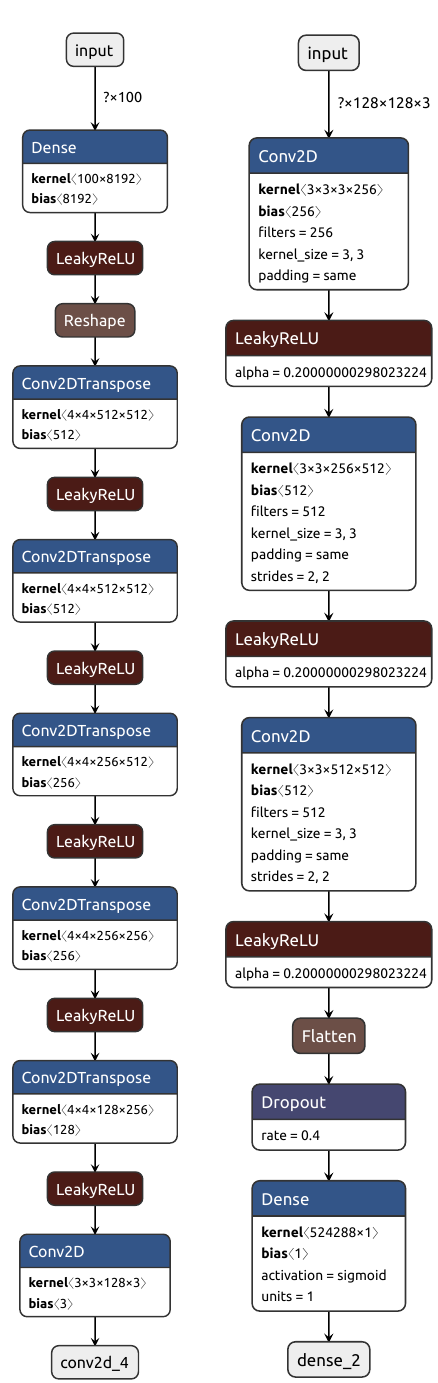
Figure A1. The architectures for the generator on the left and discriminator on the